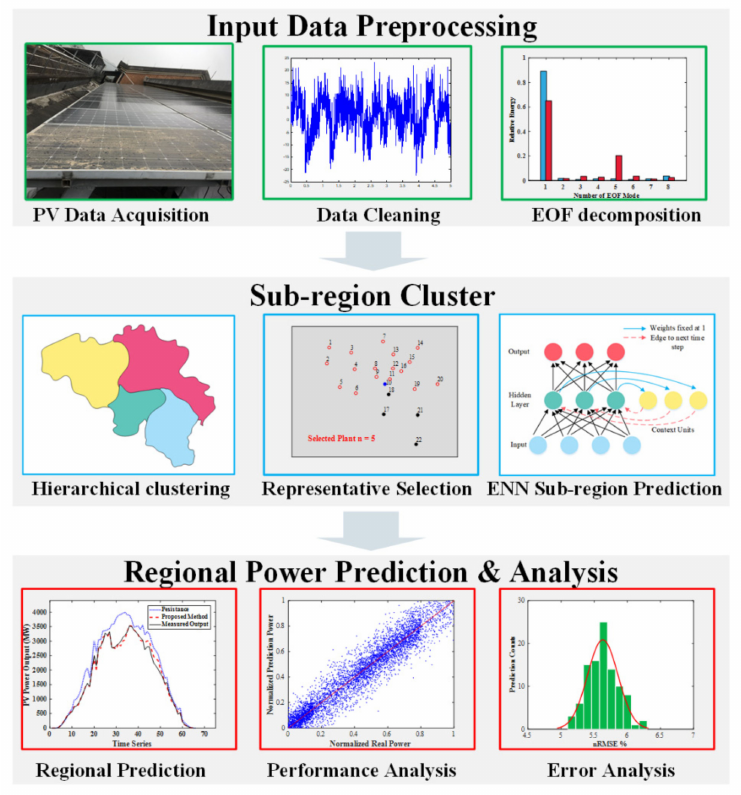
Figure 4. Main framework of the proposed